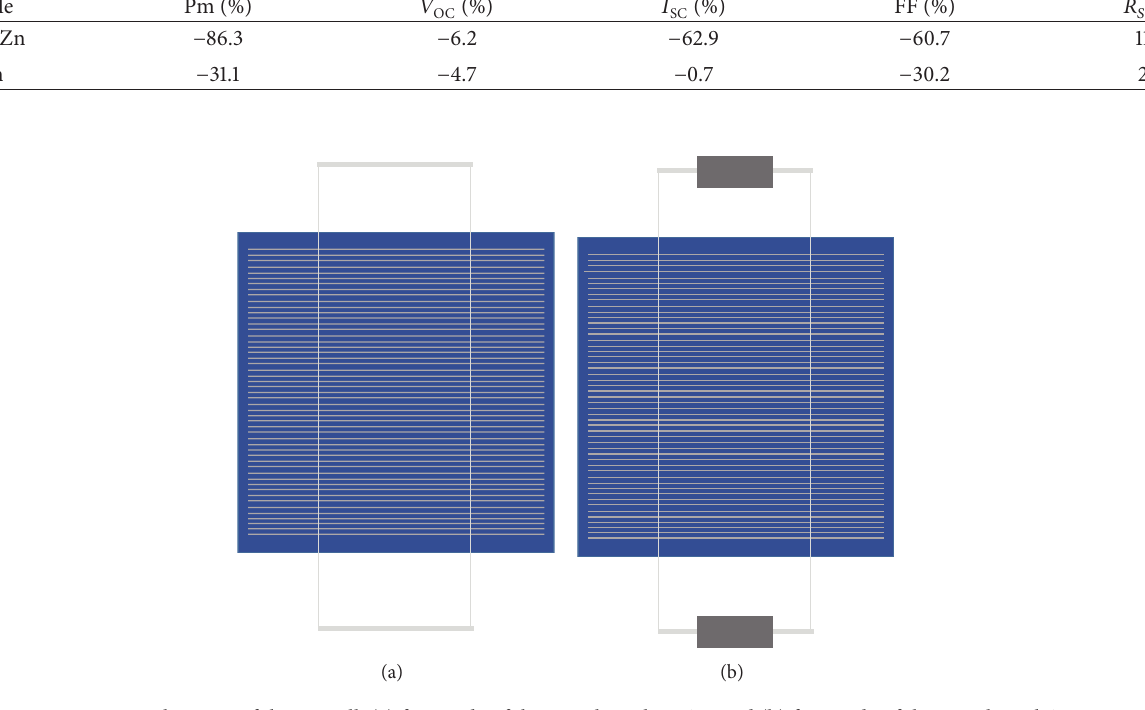
Figure 4: Schematic of the PV cell: (a) front side of the sample without Zn and (b) front side of the sample with Zn.